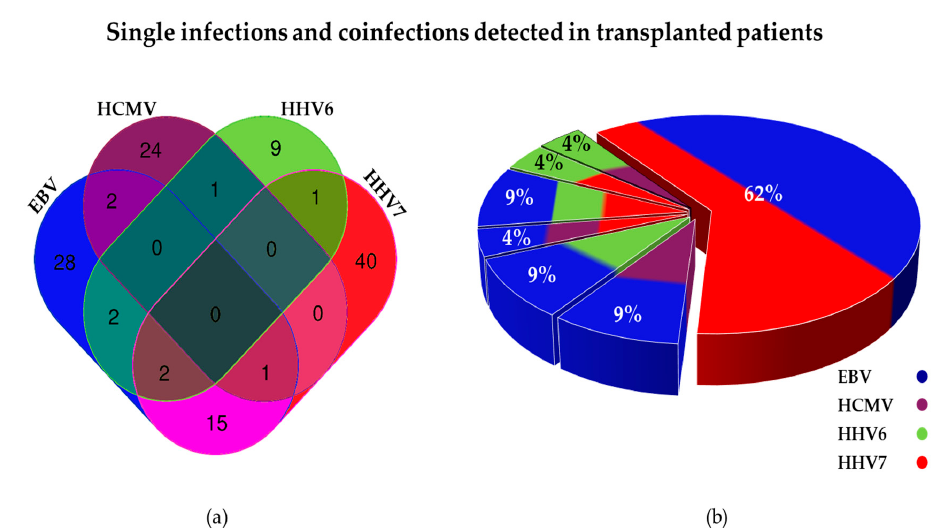
Figure 5. Single and multiple infections by beta and gamma herpesviruses detected in transplanted patients. ( a ) Venn diagram showing number of positive samples for each herpesvirus. Number of single infections can be seen at the ends of the diagram, while coinfections can be seen at overlapping areas ( N = 125). ( b ) Pie diagram showing proportions of multiple infections ( N = 24).